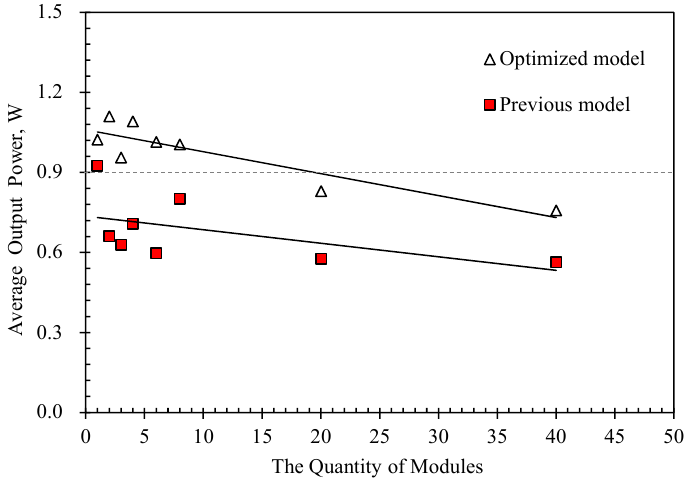
Figure 17. Average maximum output power of the optimized and previous models at different ∆ T.